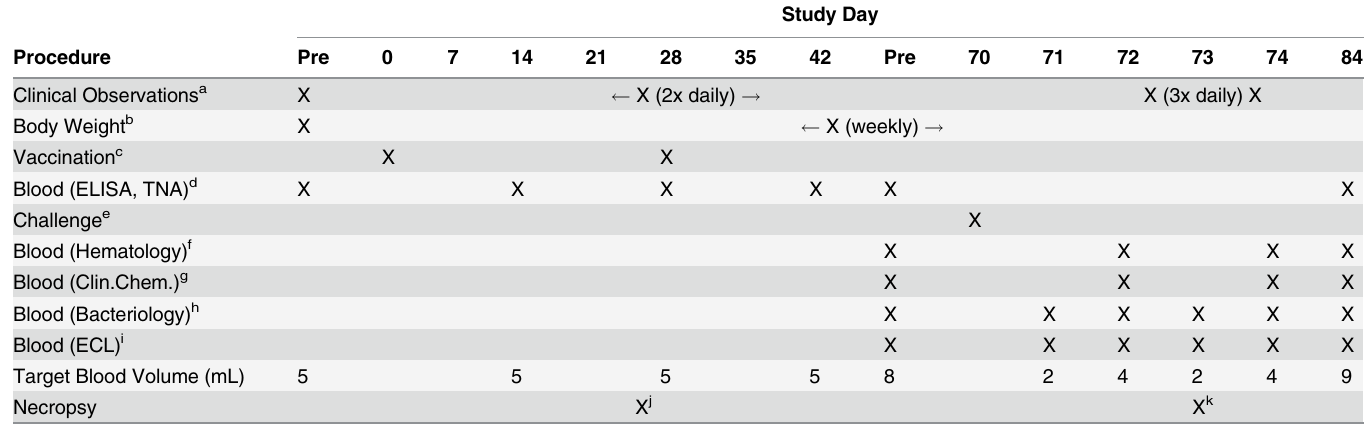
Table 2. Experimental Procedures and